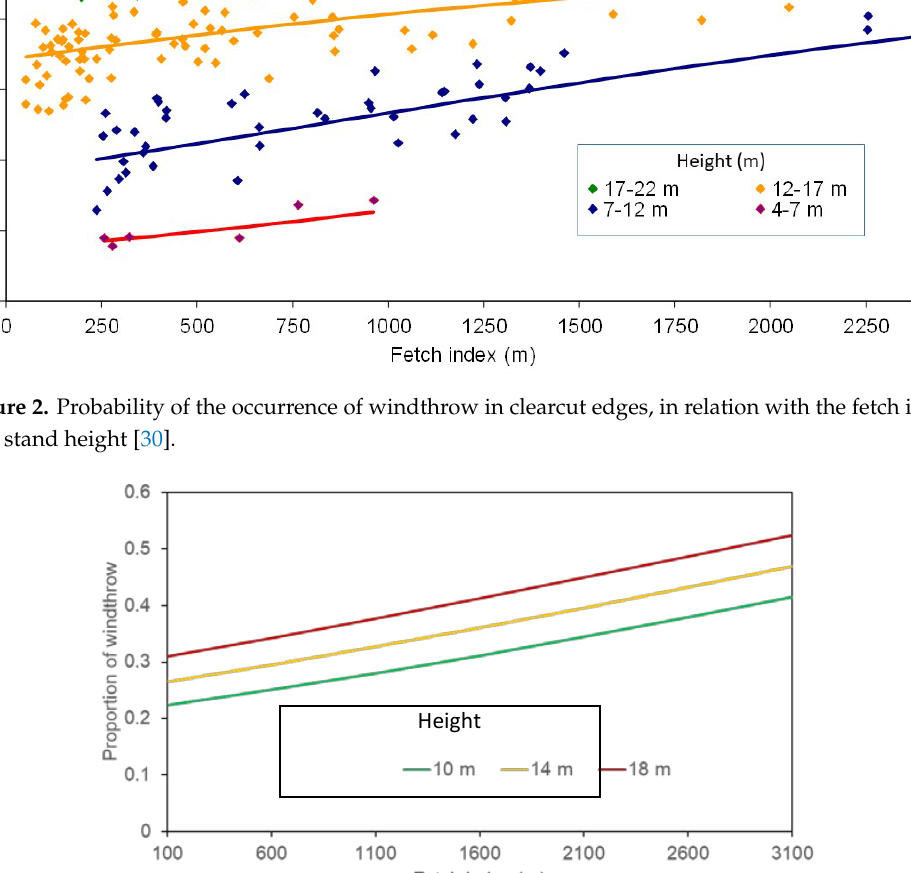
Figure 2. Probability of the occurrence of windthrow in clearcut edges, in relation with the fetch index and stand height [30].